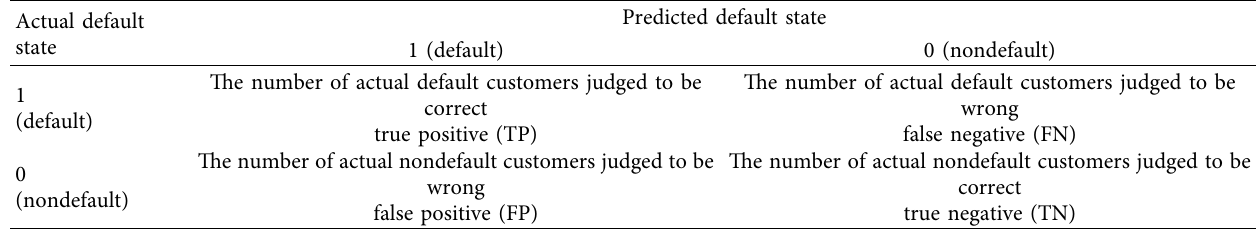
Table 3: Classified result of the predicted